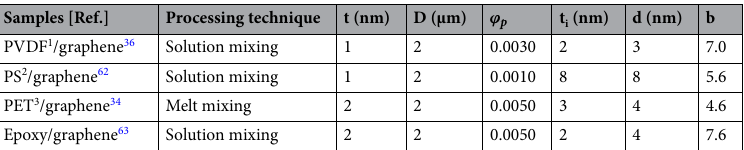
Table 1. The filler dimensions and percolation beginning of examples from original references and the calculations of tunneling length, interphase depth and “b” exponent by the mentioned equations. 1: poly (vinylidene fluoride); 2: polystyrene; 3: poly (ethylene terephthalate).